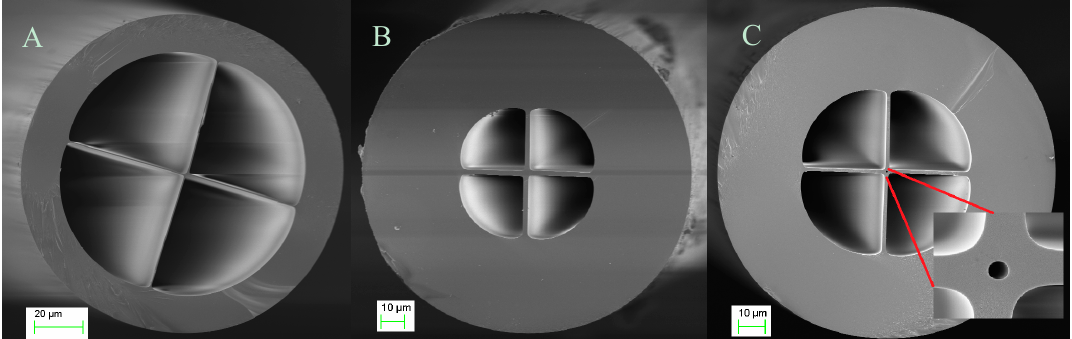
Figure 1. MOF-1 ( A ), MOF-2 ( B ) and MOF-3 ( C ) cross section. In the Figure ( C ), it can be appreciated